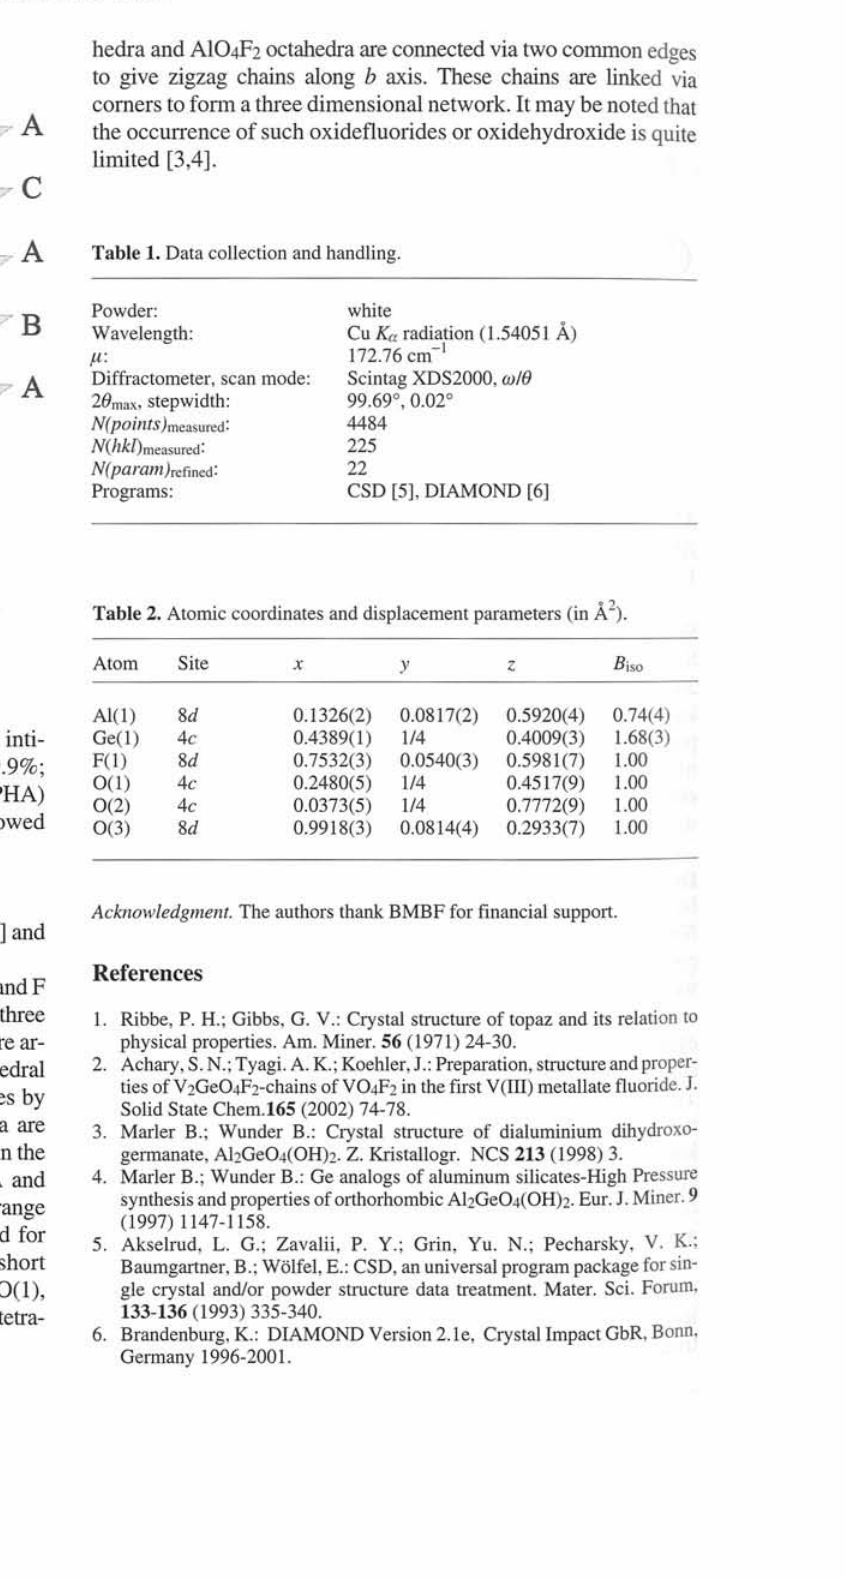
Table 1. Data collection and handling. Powder: white Wavelength: